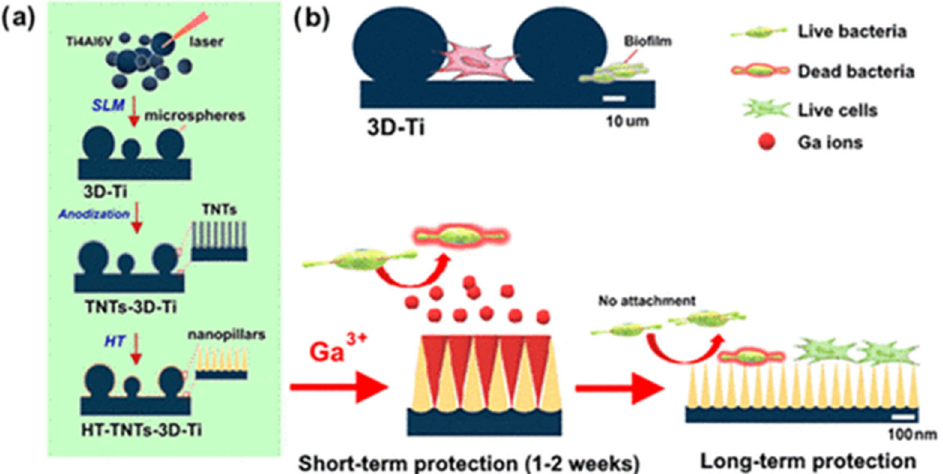
Figure 5. Schematic representation of ( a )SLM 3D printing and electrochemical anodization process for the fabrication of Titanium implants. ( b ) the mechanism for short and long-term working of the implants [120]. Reprinted with permission from. Copyright 2022 American Chemical Society.